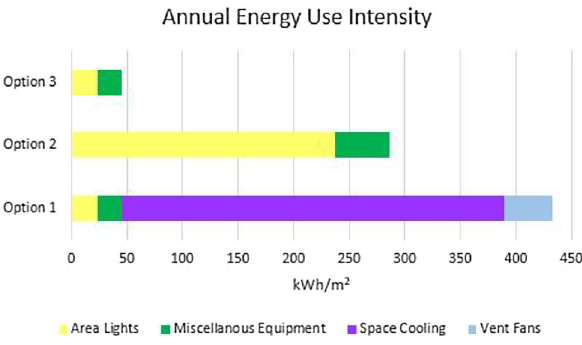
Fig. 6 Annual energy use intensity options